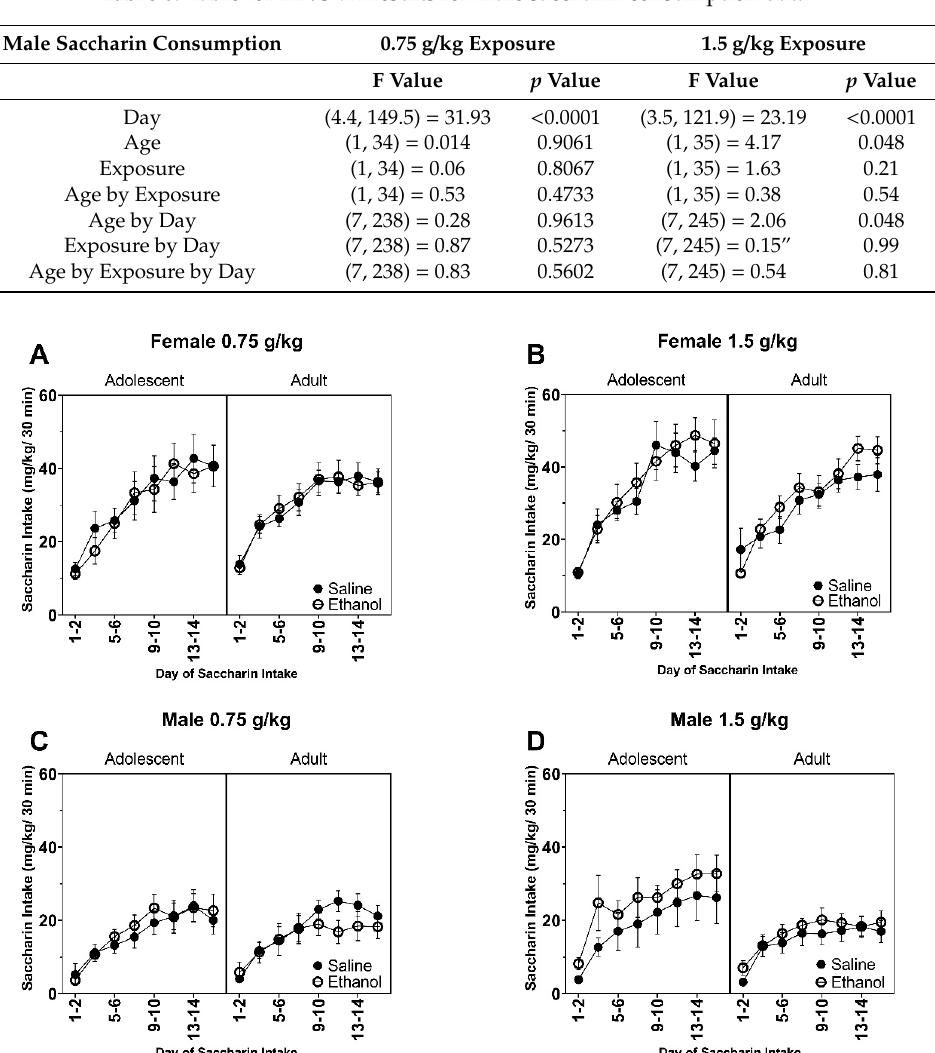
Table 6. Table for ANOVA results for male saccharin consumption data.